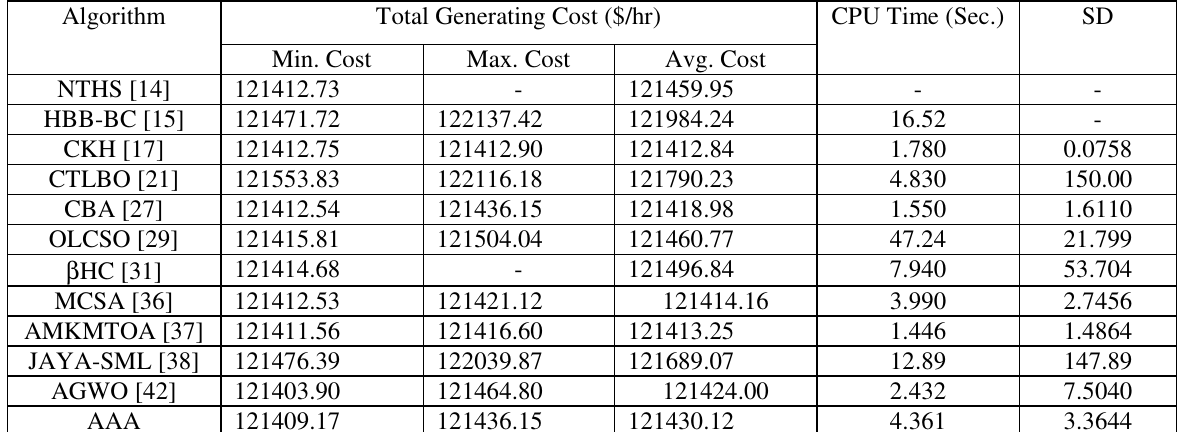
TABLE 5: COMPARISON OF RESULTS FOR TEST CASE 5 Algorithm